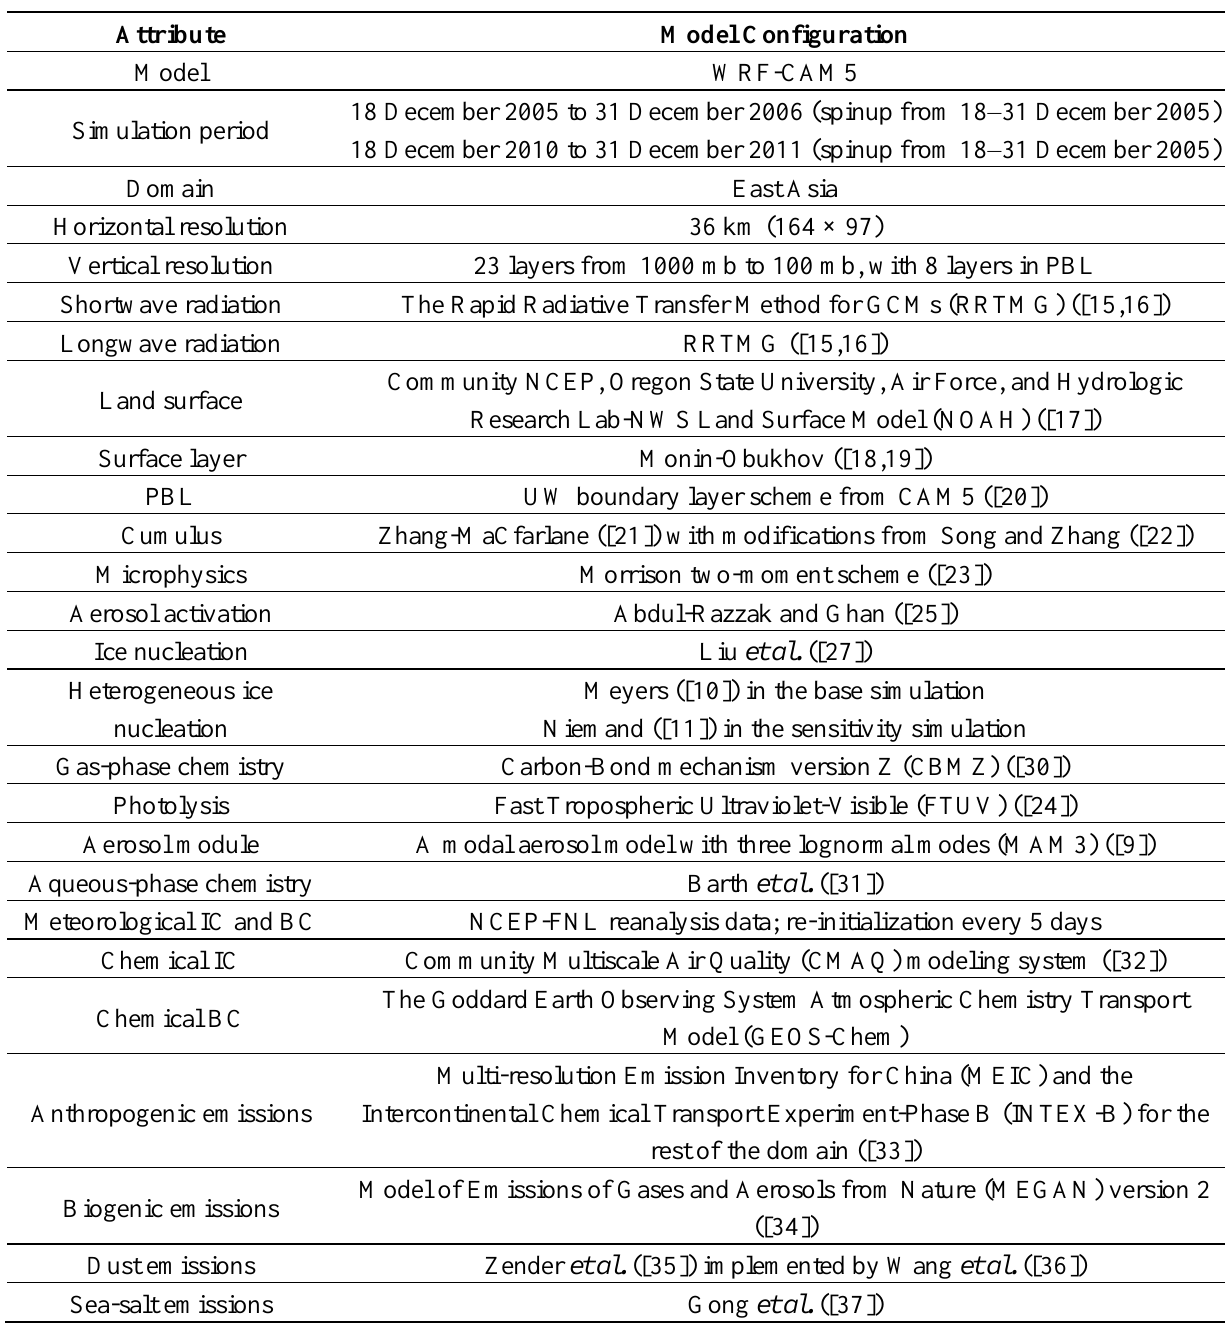
Table 1. Model configurations and inputs used in this